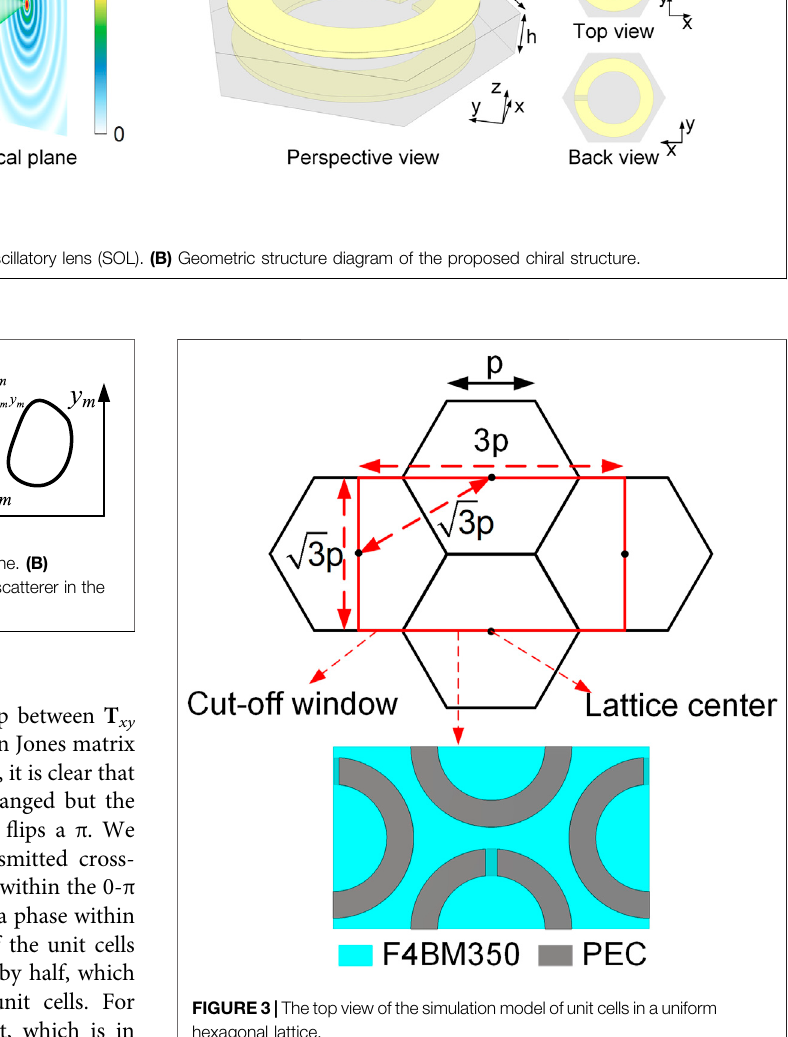
Frontiers in Materials |